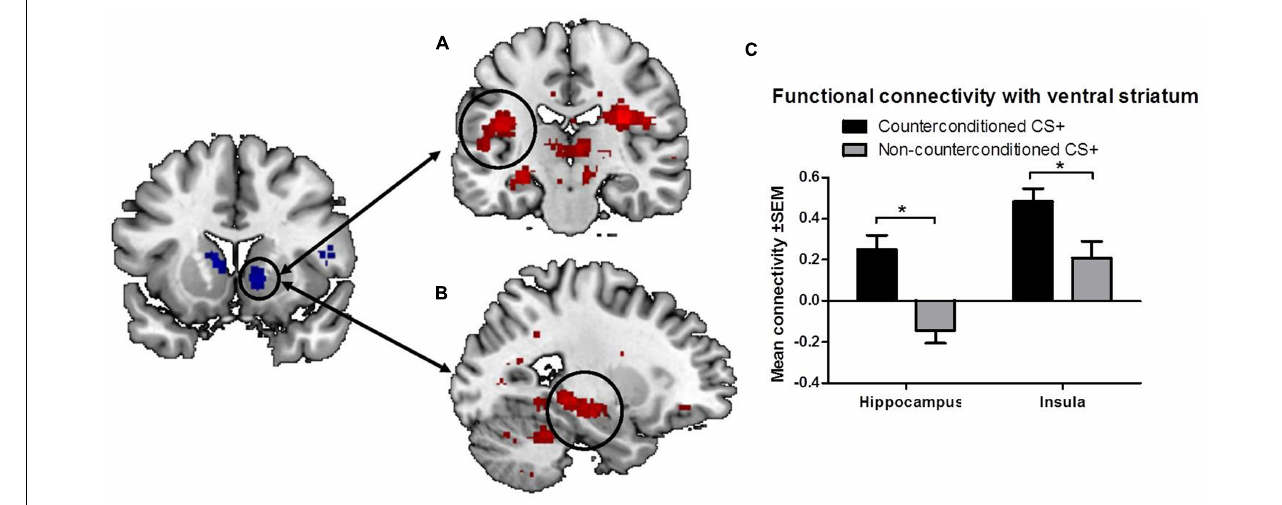
FIGURE 3 | Functional connectivity of the ventral striatum. The figure shows significant differences in functional connectivity for the counterconditioned versus non-counterconditioned CS + following reinstatement. Counterconditioning strengthened the functional connectivity of the ventral striatum seed region (left) with the left insula (A) and left hippocampus (B) . The figures are displayed at p < 0.001 uncorrected for visualization purpose. The graph (C) is a visual representation of the functional connectivity changes with the ventral striatum in response to counterconditioned and non-counterconditioned CS + , in the insula and hippocampus. ∗ = whole brain significant main effect of stimulus type (CS + cc versus CS + nc ) on ventral striatal connectivity following reward